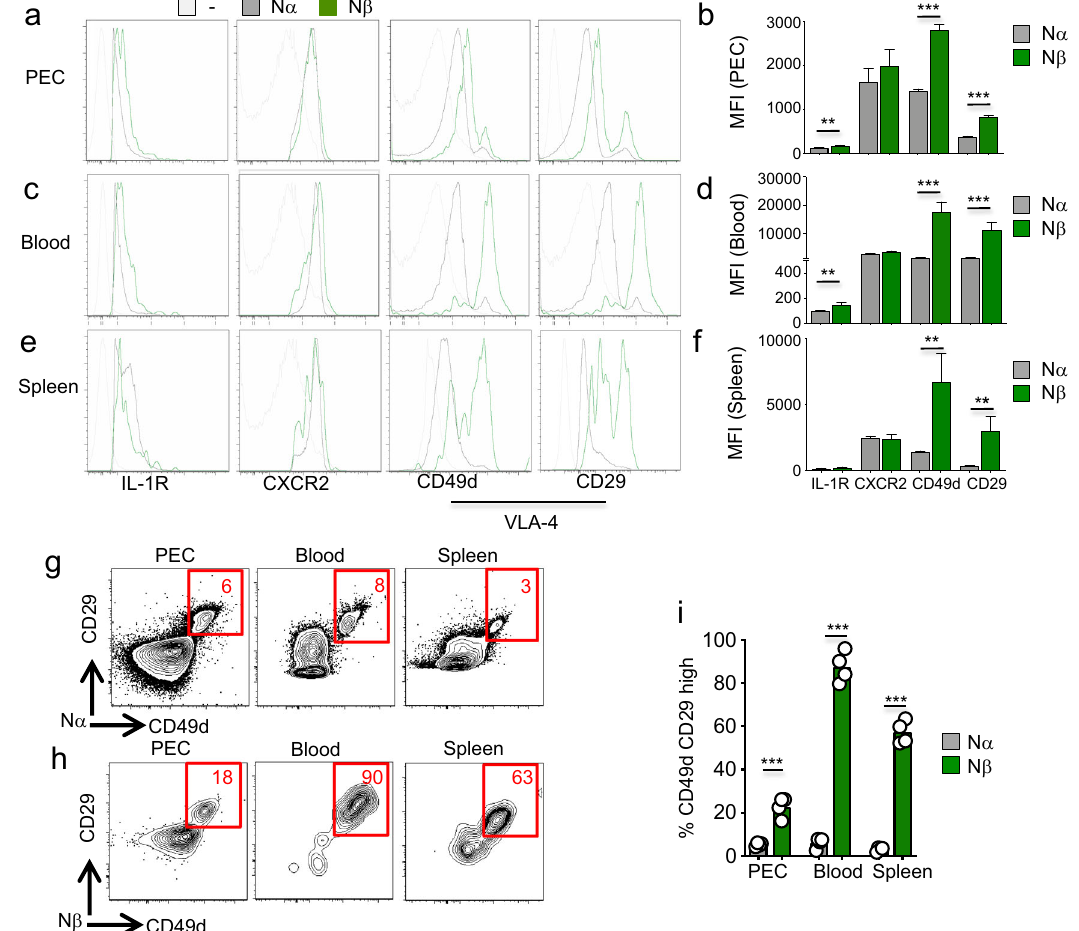
Fig. 4 Different expression of VLA-4 integrin by distinct neutrophil subsets. Layouts and median fl uorescence intensity (MFI) of IL-1R, CXCR2, CD49d, and CD29 in N α (gray) and N β (green) neutrophils at 6 h post infection in PEC ( a – b ), blood ( c – d ), and spleen ( e – f ) of NYVAC-C Δ 3-injected mice. Isotype control in gray. Columns show mean ± SEM of four mice. Contour plots of CD29 and CD49d markers of N α ( g ) and N β ( h ) neutrophils from PEC, blood, and spleen of NYVAC-C Δ 3-injected mice at 6 h post infection. Percentages of CD49d and CD29 high N α (gray) and N β (green) neutrophils from PEC, blood, and spleen of NYVAC-C Δ 3-injected mice ( i ). Graphs show mean; each point represents an individual mouse. Data are representative of three independent experiments. ** P < 0.01, *** P <